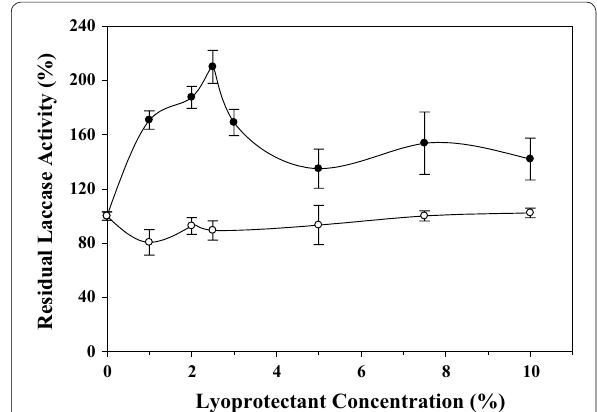
Fig. 2 Effect of the lyoprotectant concentration (%, w/v) of dextran 5 to 25 kDa (black circle) and mannitol (white circle) on the residual laccase activity. The residual laccase activity was defined as the specific activity of lyophilized enzyme to that of the lyophilized enzyme trial that is lacking the additive